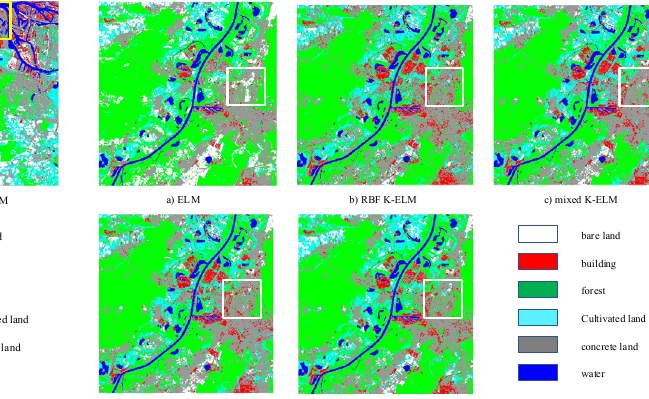
Figure 4 . Classification result of Hamburg dataset.